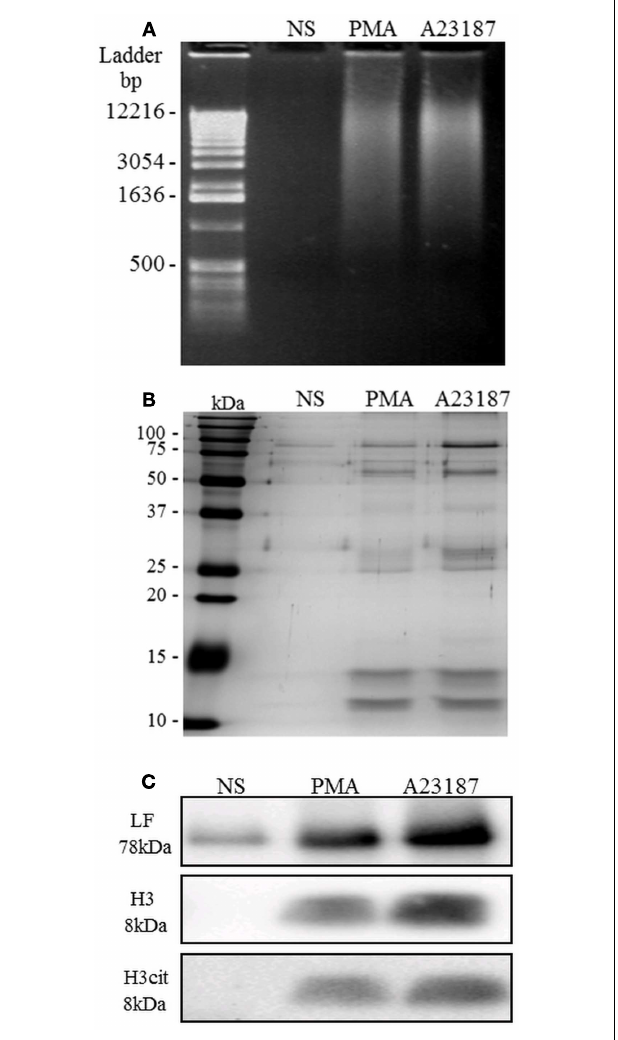
FIGURE 4 | NETs are recovered afterAluI treatment of activated PMN . Unstimulated PMN and PMA- or A23187-stimulated PMN were treated with the restriction enzyme Alu-I. (A) NET samples migrated on agarose gel were stained with ethidium bromide: dsDNA fragments were revealed as a smearing pattern along the gel. (B) Visualization of NET protein content by silver staining. Few proteins were observed in the untreated sample, whereas numerous proteins were observed in PMA- and A23187-NET samples, with similar profiles. (C) Identification of three specific NET proteins (LF, H3, and cit-H3) by immunoblotting. Cit-H3 is a signature of netosis.These experiments were repeated at least six times with PMN from different healthy